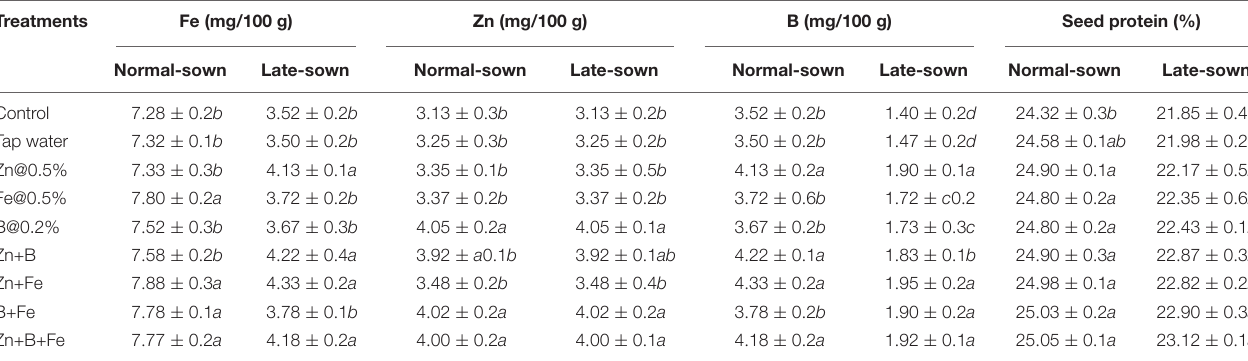
Values are means, and numbers with parentheses are ± SEM (n = 3). Different letters indicate significant differences between